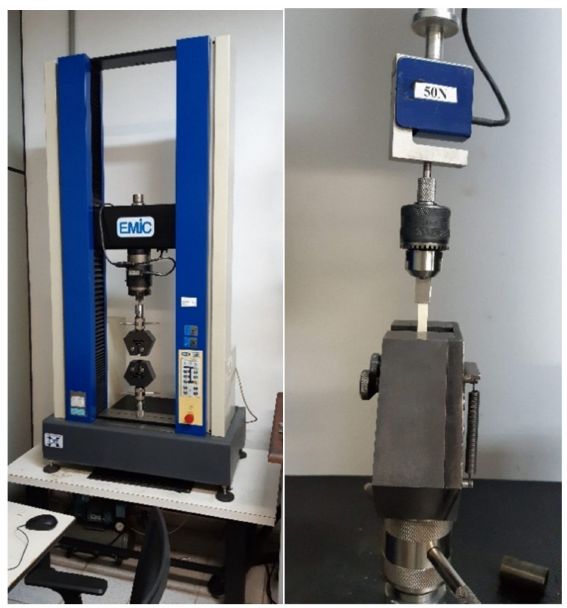
Figure 1. Tensile testing